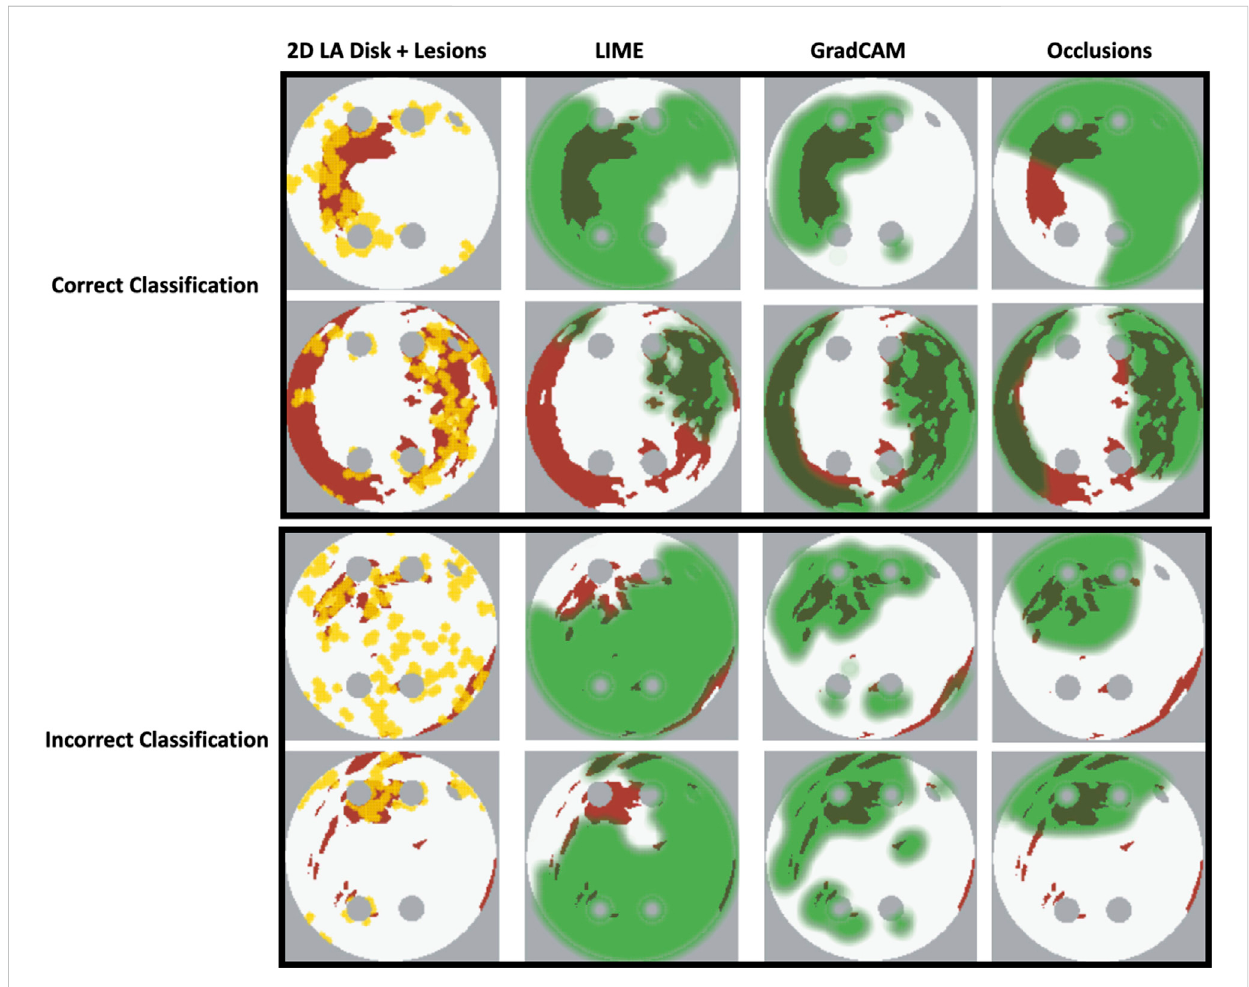
FIGURE 11 Correct and incorrect classi fi cation examples of FA maps (LIME, GradCAM and occlusions) for